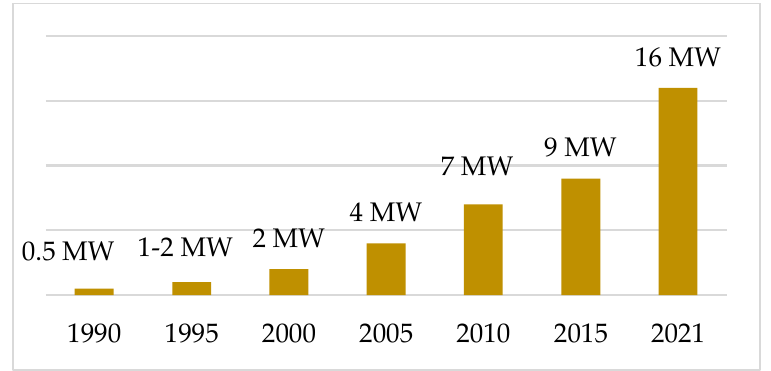
Figure 1. Wind power evolution.